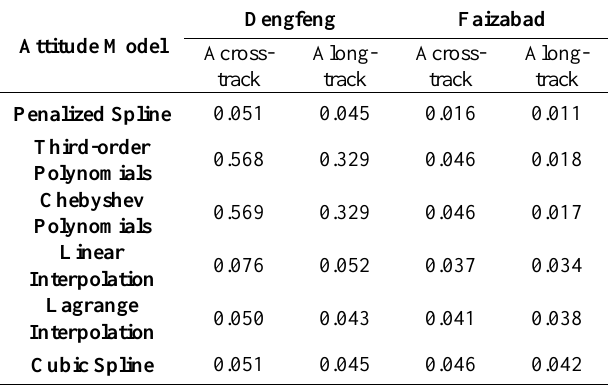
Table 2 RMSE of misregistration of band 1 to band 3 caused by attitude